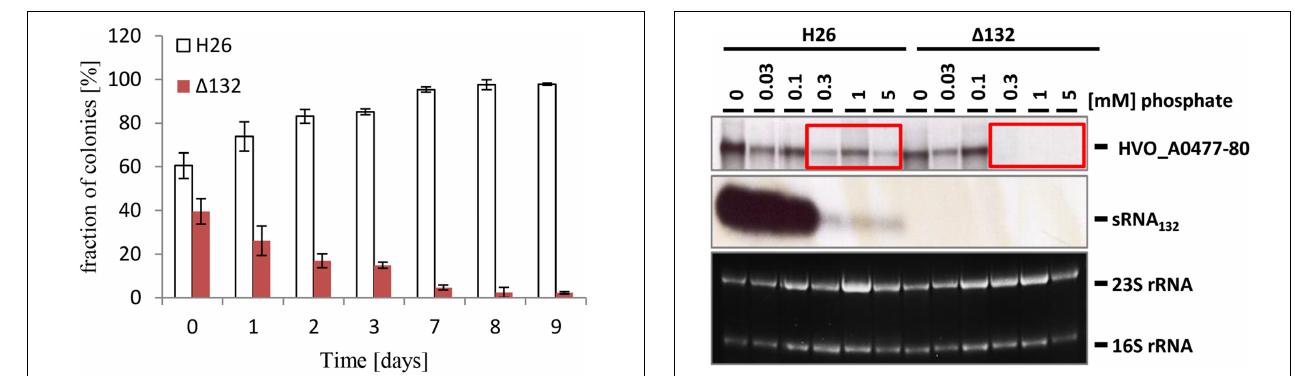
FIGURE 2 | Competitive growth between the wild-type and a sRNA132 gene deletion mutant. The sRNA132 gene deletion mutant had the normal red color of H. volcanii . The sRNA132 wild-type was white due to the deletion of the carotenoid-biosynthesis gene HVO_2528. Both strains were grown to mid-exponential phase and mixed to nearly equal rations. The mixture was grown overnight, an aliquot was taken and dilutions were plated to enable quantification of the numbers of red and white colonies. The overnight culture was also used to inoculate a fresh culture, and this procedure was repeated for 9 days. The fractions of red and white colonies are shown.